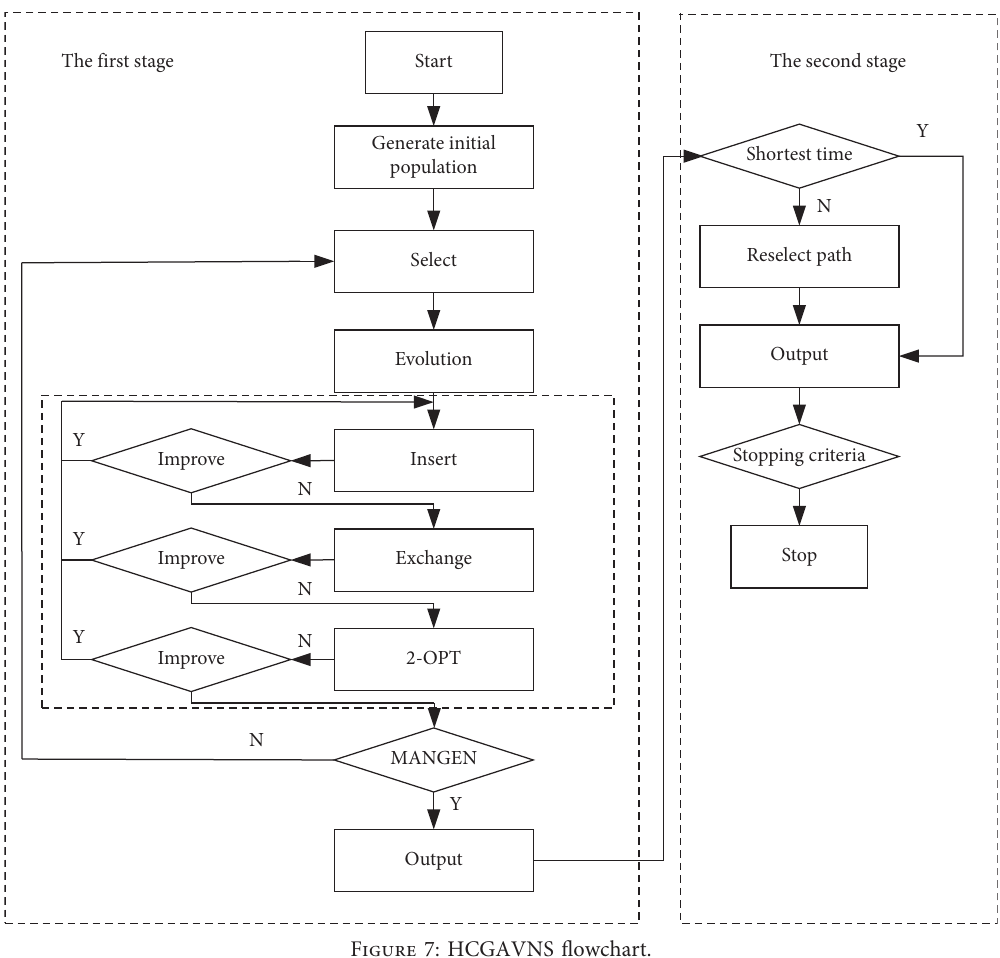
Figure 7: HCGAVNS